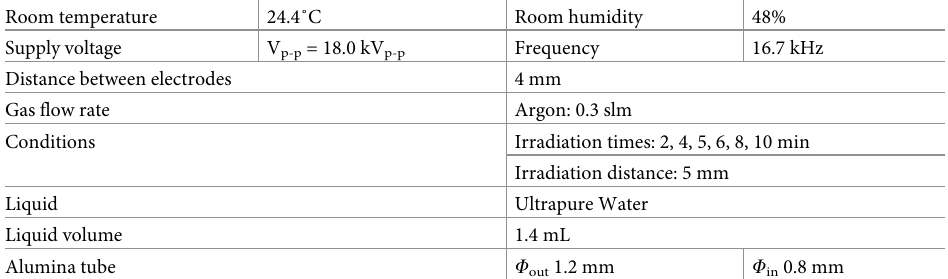
Table 2. Experimental conditions and settings for reactive species measurements produced by the plasma